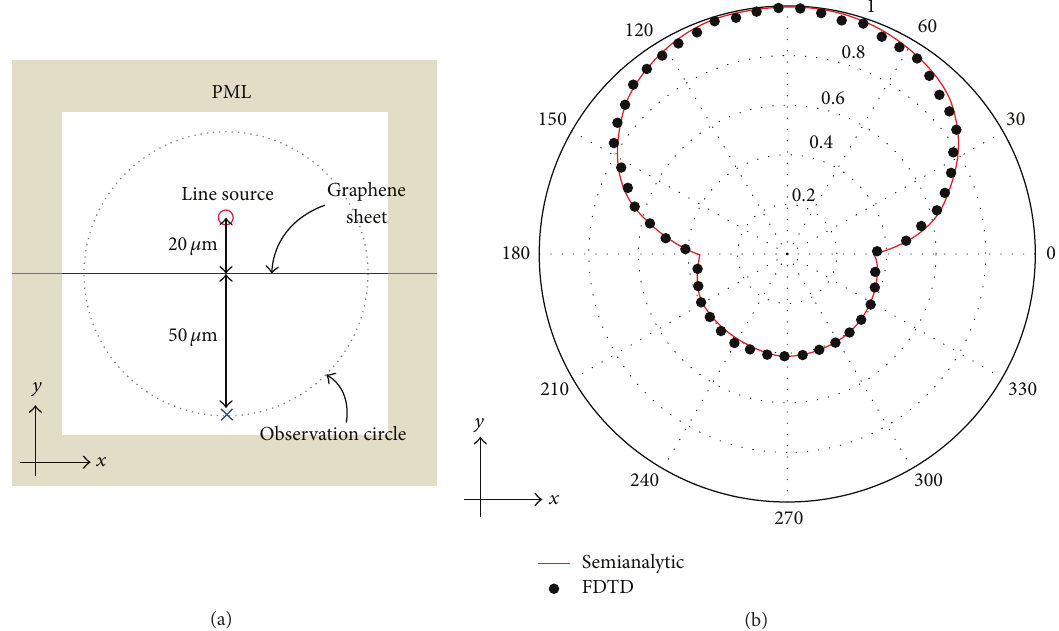
Figure 5: (a) Line source scattering by a graphene sheet. (b) Normalized pattern of 𝐸 𝑧 at the wavelength of 𝜆 0 = 100 𝜇 m [28].